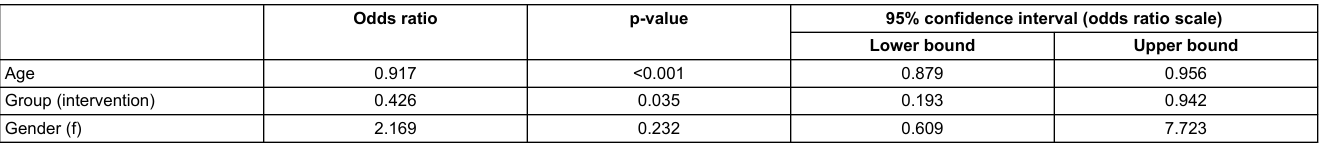
Table 4: Coefficients for patients aged ≥60